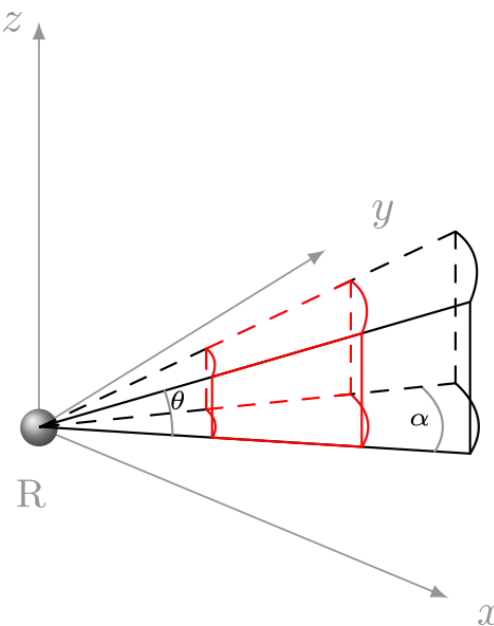
Figure 1. RSVP column (outline in red), covering an arbitrary vol- ume in range and in